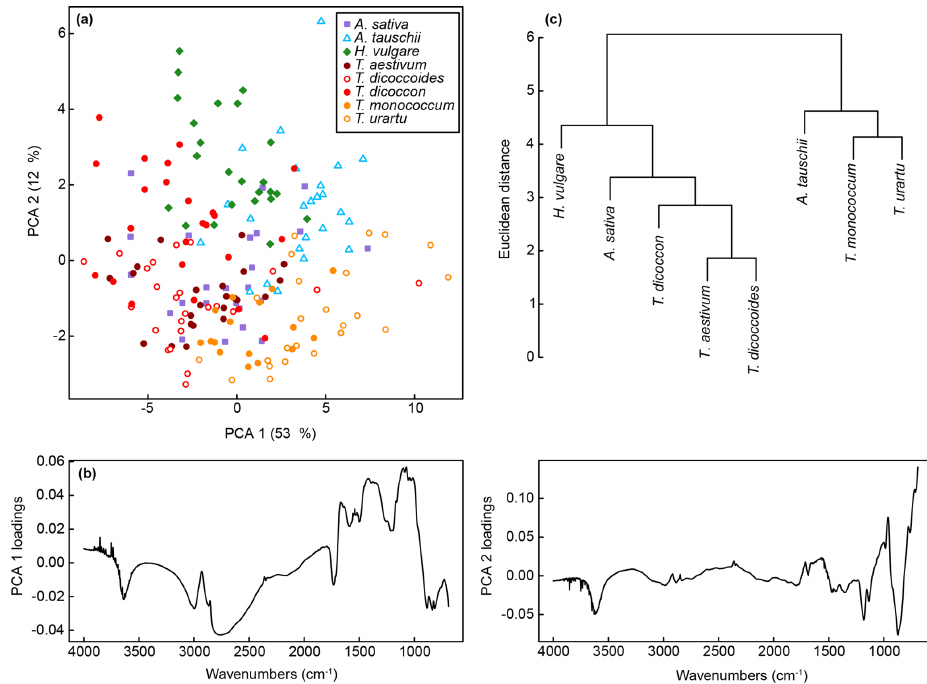
Figure 3. (a) PCA of unprocessed FTIR spectra. Values in parentheses show the percentage variance explained by each PCA axis. See Fig. S2 for PCA axes three to six. (b) Loadings for PCA axes one and two. (c) Cluster analysis of unprocessed FTIR spectra, based on the mean spectrum for each species. Table 2. Maximum classification success rate on the training dataset, with the best parameter combinations from the different spectral processing approaches. k is the number of nearest neighbours in the k -nn classification algorithm, and w is the window size in the Savitzky– Golay smoothing